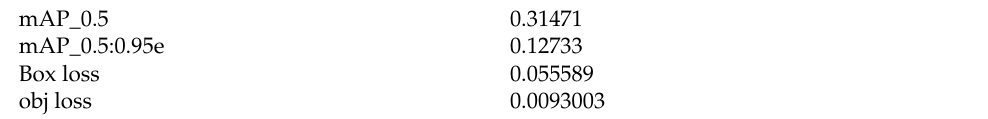
Table 6. Validation on SEAGULL and COCO combination—values of